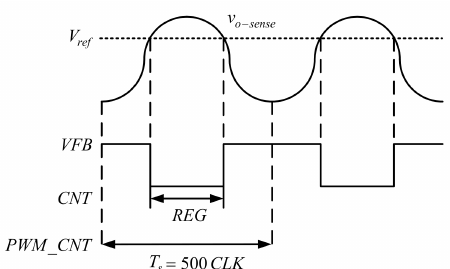
Figure 13. Output voltage ripple with nonlinearity.